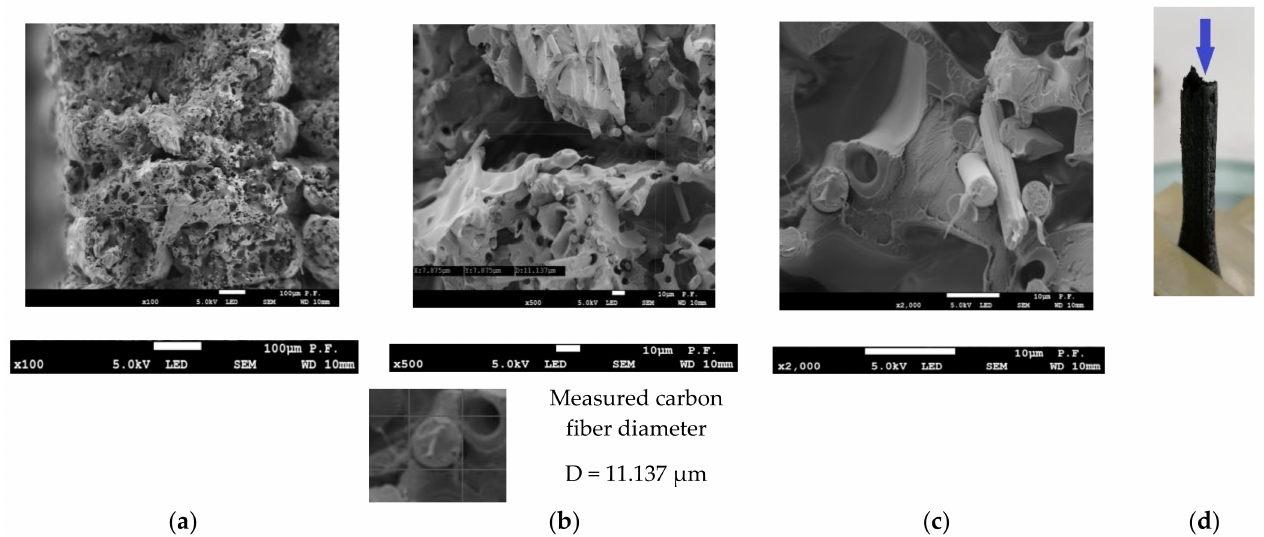
Figure 19. Cross-sectional views of a 1.8 mm thick PLA-CF specimen after failure, ( a ) × 100 magnification, visible voids in the material and a gap between the layers ( b ) × 500 magnification, area of local fracture; cross-sectional view of a carbon fiber (measured diameter) is provided below, ( c ) broken carbon fibers and holes where fibers were, × 2000 magnification, ( d ) view of the tested sample.